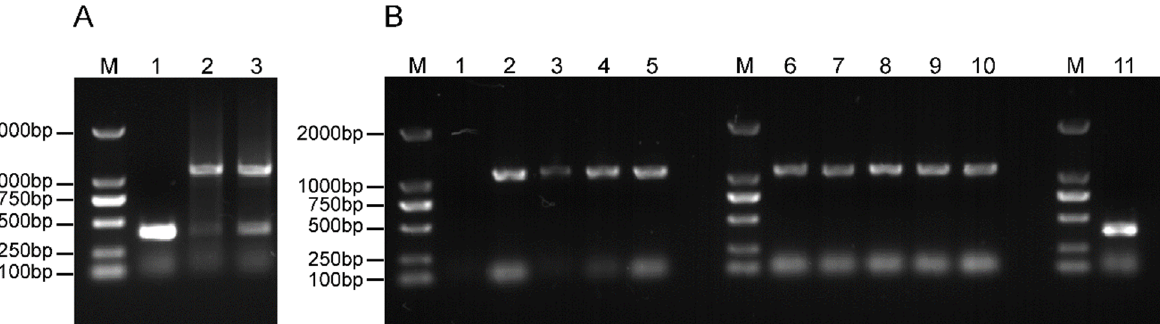
Figure 3. RT-PCR electrophoresis of reporter DENV. ( A ) RT-PCR of impure reporter DENV. Primers were designed to start at the 5 ′ UTR and end at the capsid gene, and the amplified fragment size was 1094 bp. The inserted NLuc fragment size was 690 bp. M: DL2000 marker; 1: DENV(WT); 2: DENV(WT)-NLuc; 3: DENV(T155I)-NLuc. ( B ) RT-PCR of plaque-purified reporter DENV. The am- plified fragment of the virus with the NanoLuc reporter gene was 1094 bp, and the amplified frag-